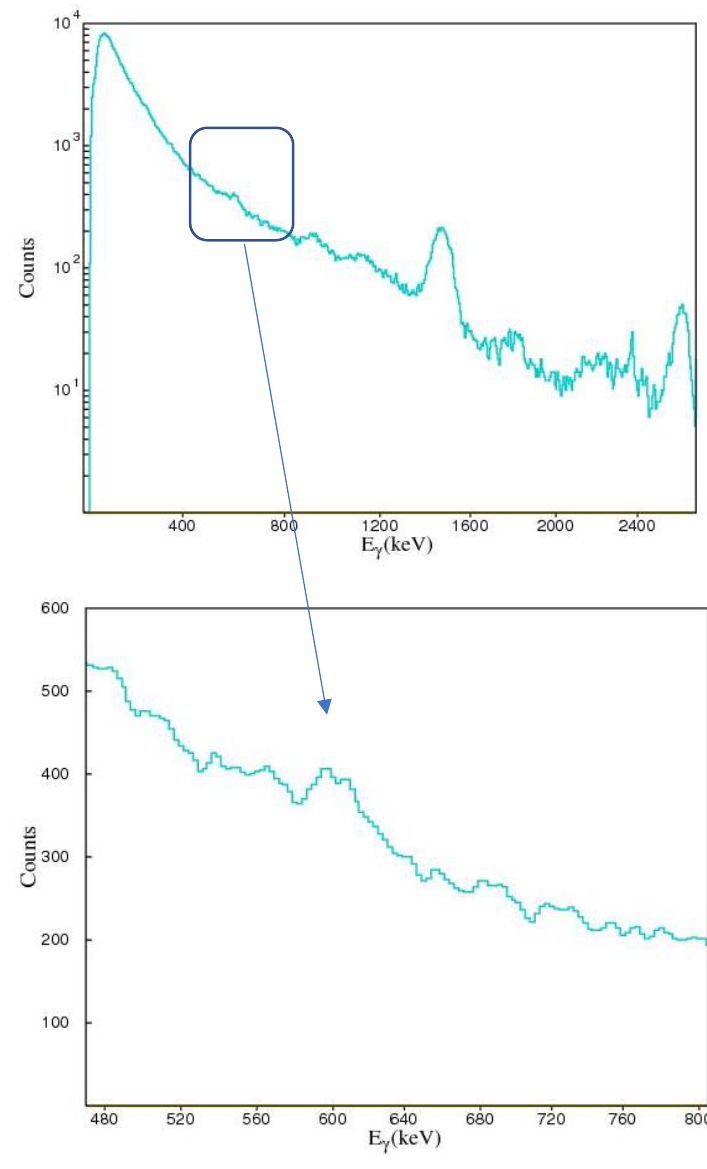
Figure 4. The measured spectrum using the KATERINA system placed on the seabed (1 h measure- ment). A zoom window around 661 keV is depicted. The peaks identified in Figure 3 are clearly seen. The arrow indicates the energy window of the emission energy of 137 Cs.